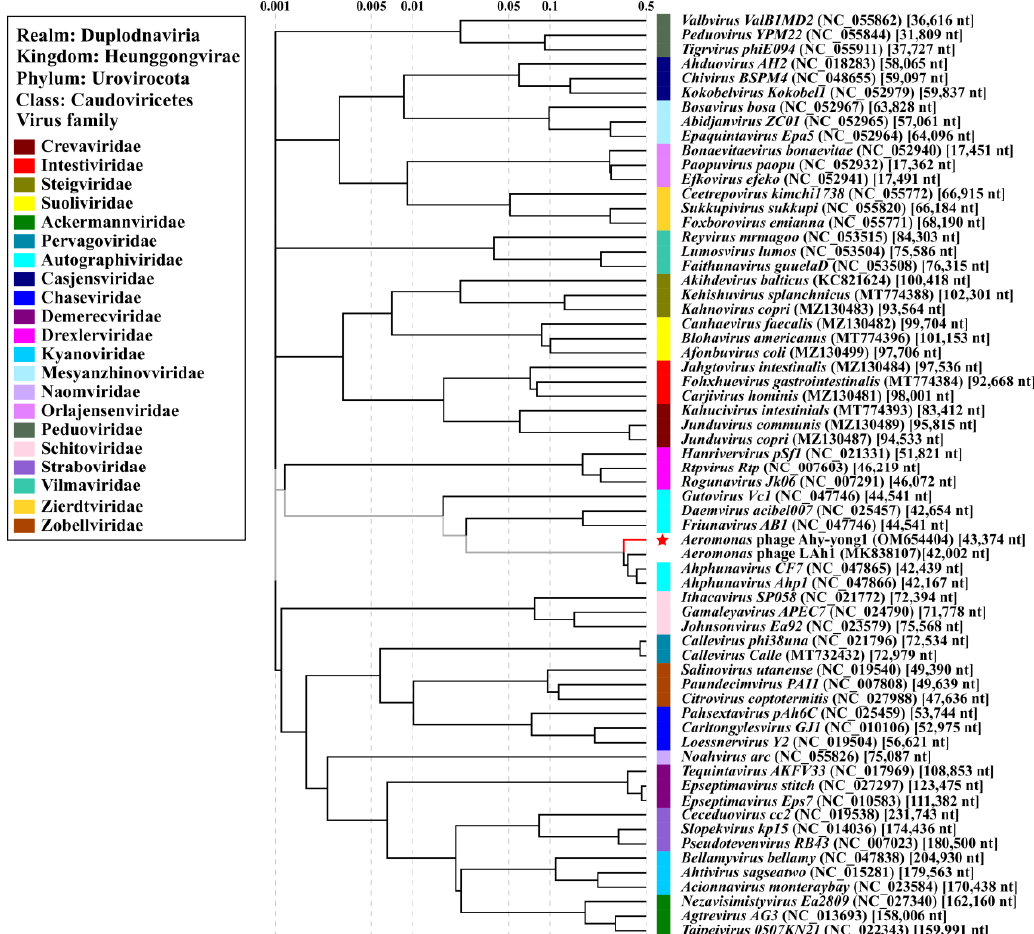
Figure 7. Proteomic tree based on the complete genome sequences of Aeromonas phage Ahy-yong1, 62 classified phages of Caudoviricetes class with shorter evolutionary distance from Ahy-yong1 in the original tree and unclassified Aeromonas phage LAh1 sharing the top highest homology with Ahy-yong1 in BLASTn scanning. Bacteriophage family assignments according to the official ICTV classification (March 2022) are provided with different color bars. The red star indicates phage Ahy-yong1. In the proteomic tree, Aeromonas phage Ahy-yong1 clustered with Aeromonas phages of the family Autographiviridae , especially closely related with Aeromonas phage LAh1, Ahp1, and CF7.